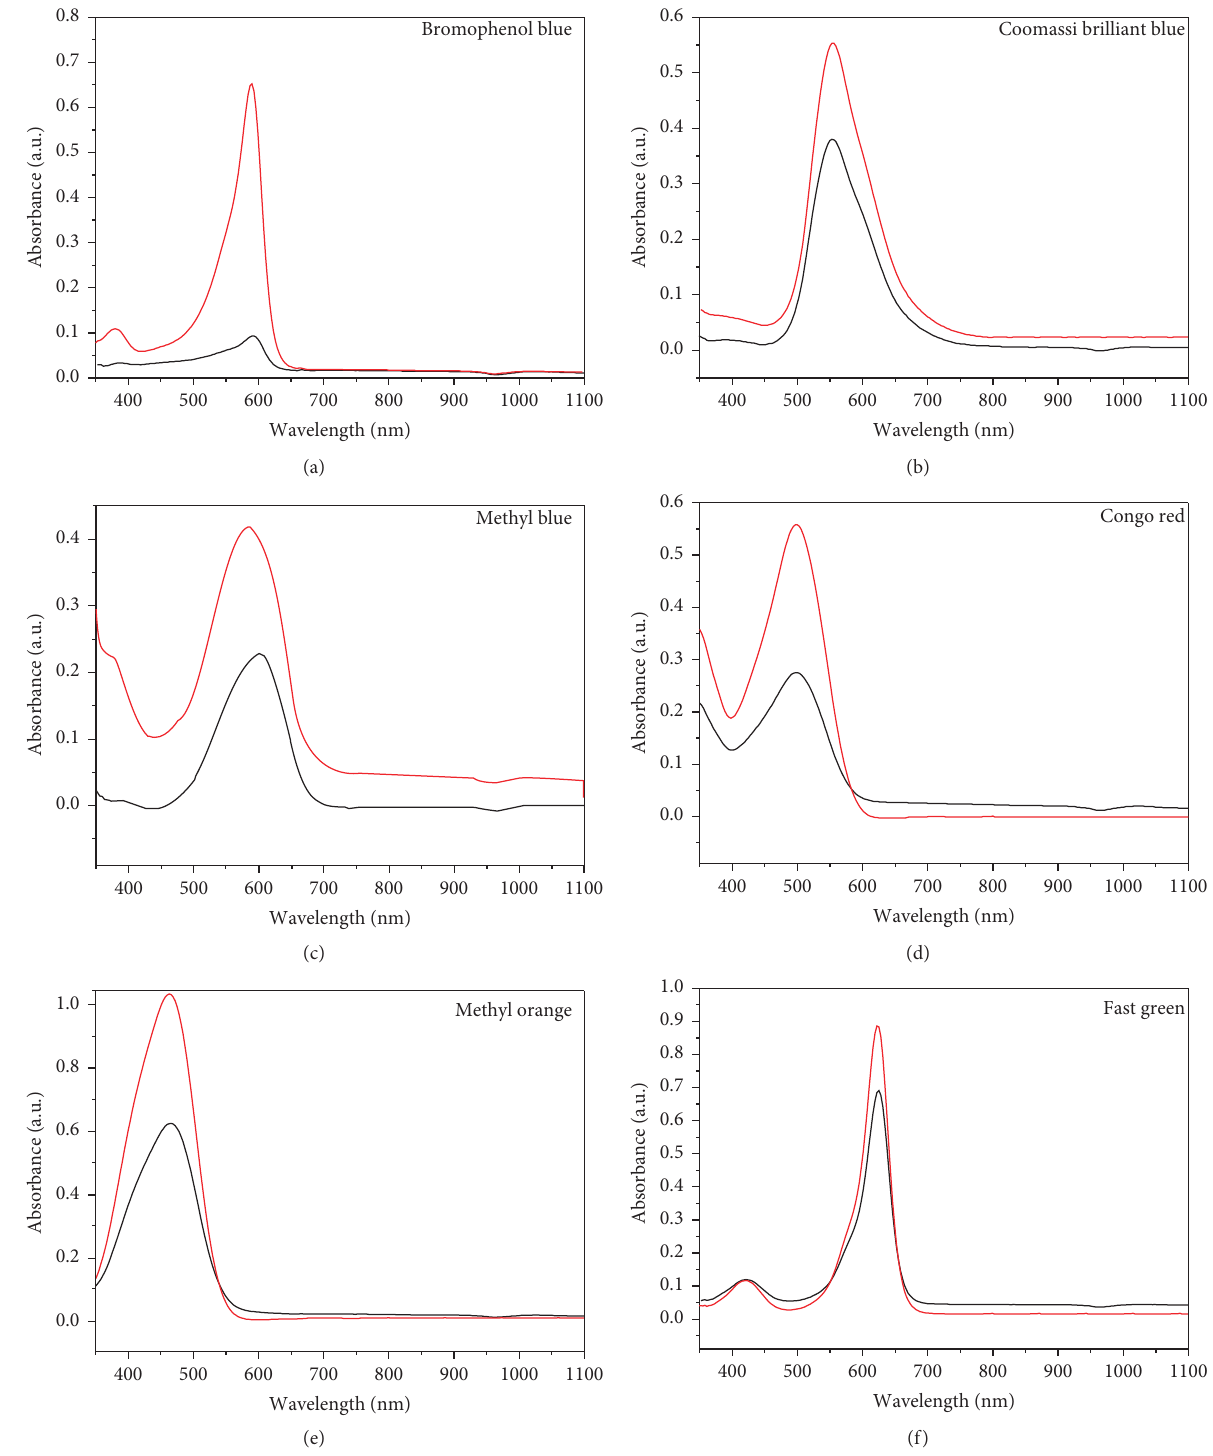
Figure 12: HPLC chromatograms of the direct injection of a standard spiked with the analytes (black line) and after preconcentration using the fabricated polycarbonate microchip containing CuBTC-monopol monolithic disk (red